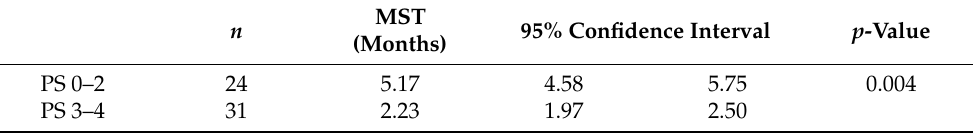
Table 4. Survival time of patients with a PS of 0–2 versus those with a PS of 3–4. n